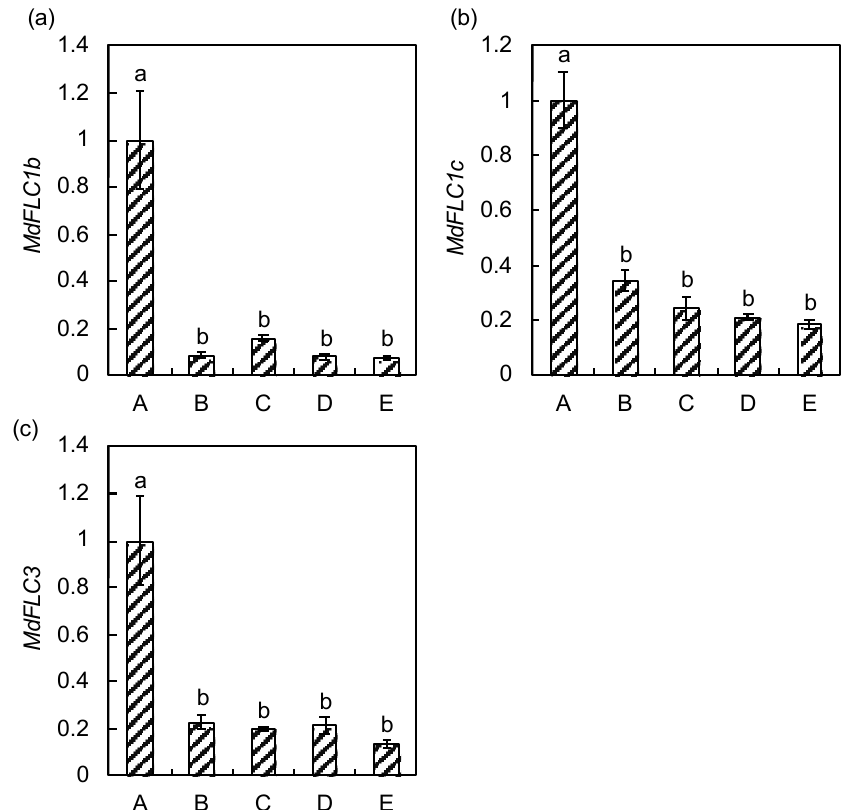
Figure 4. Changes in the expression levels of MdFLC1b ( a ), MdFLC1c ( b ), and MdFLC3 ( c ) during phase transition in apple seedlings. The expression level of MdFLC1a was undetectable. Total RNA was prepared from the juvenile phase (A), transition phase (B and C), and adult phase (D and E) in early July 2009 as described in [27]. Relative expression was determined in triplicate measurements taken from three independent biological replicates. The relative expression levels were normalized against MdACTIN with standard errors, and the maximum level of the transcripts was set at 1.0. The values with di ff erent letters for each gene significantly di ff ered between positions at p < 0.05 according to a Tukey test.